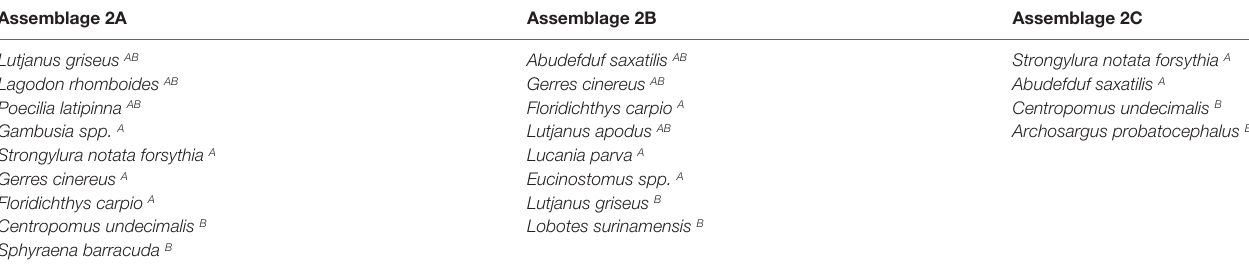
TABLE 4 | List of species that distinguished each Assemblages 2A, 2B, and 2C from each other, based on the SIMPER results and abundances and biomass of fish